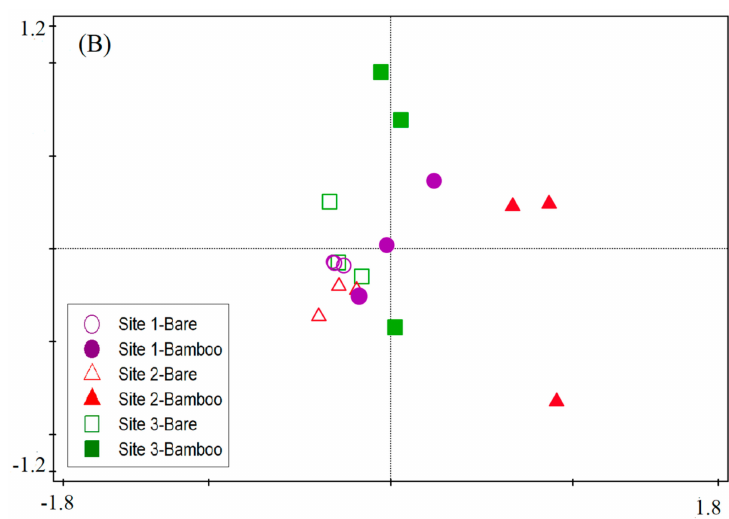
Figure 3. Redundancy analysis on soil enzyme activities, and environmental factors from soil samples collected at di ff erent locations ( A ). ( B ) shows site code for each sample. Bare land (open), Bamboo plantation (solid) soil.